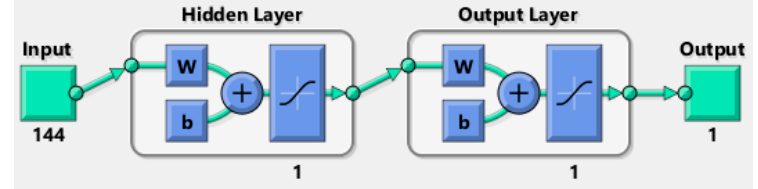
Figure 3. Multilayer perceptron (MLP) architecture for fault location.